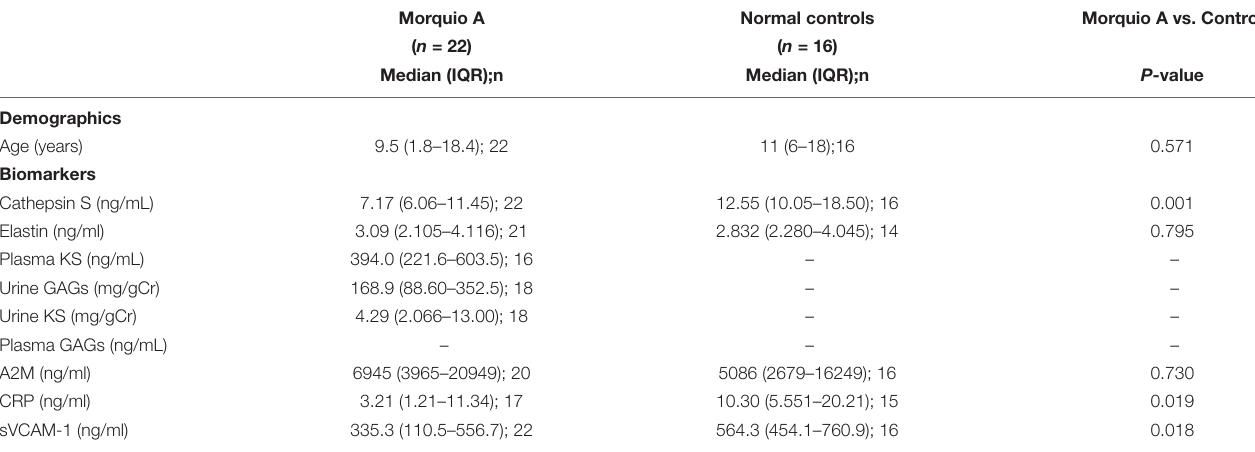
TABLE 5 | Demographic and cardiovascular disease biomarker comparisons of Morquio A patients and normal controls. Morquio A Normal controls Morquio A vs.